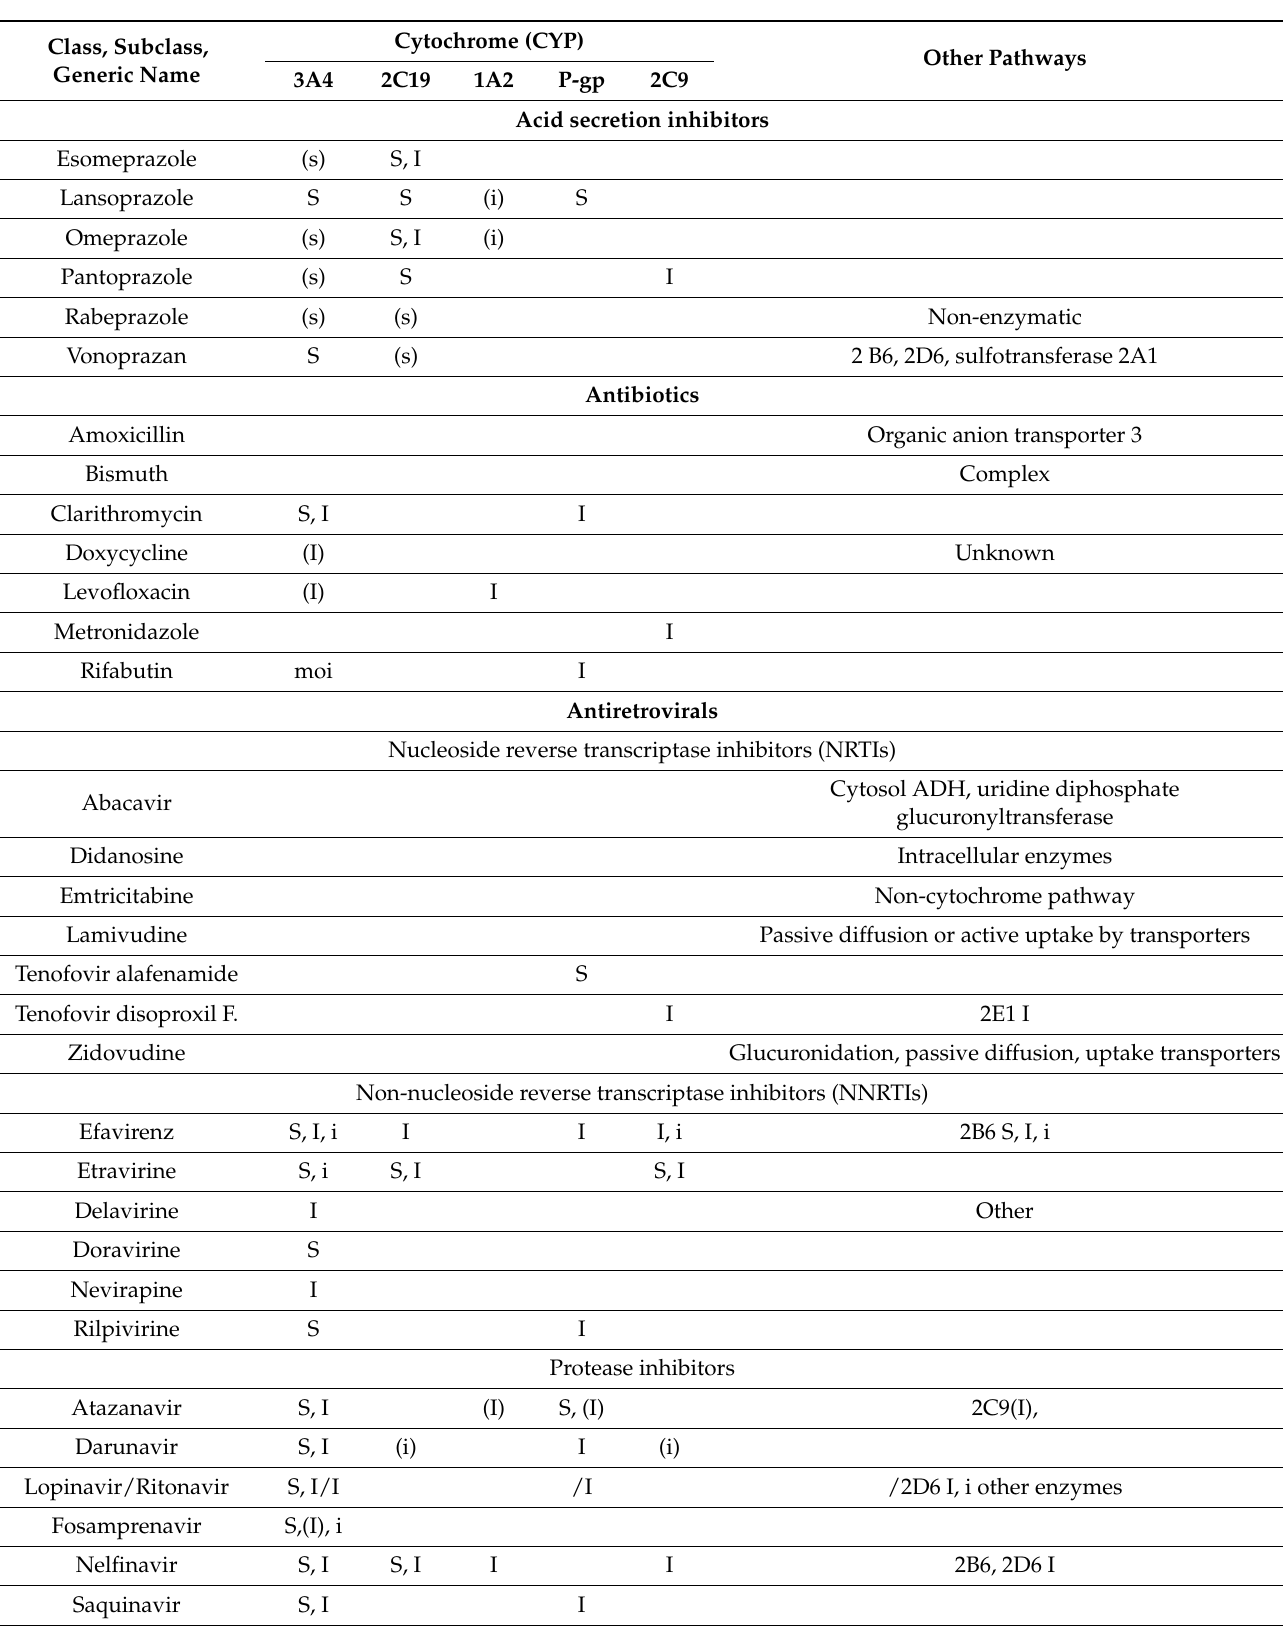
Table 1. Metabolic pathways of acid secretion inhibitors, antibiotics, and antiretrovirals (adapted from